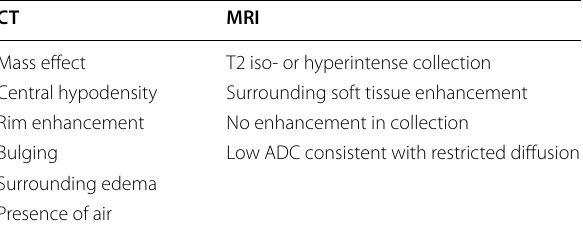
Table 3 Diagnostic criteria for an abscess in CT and